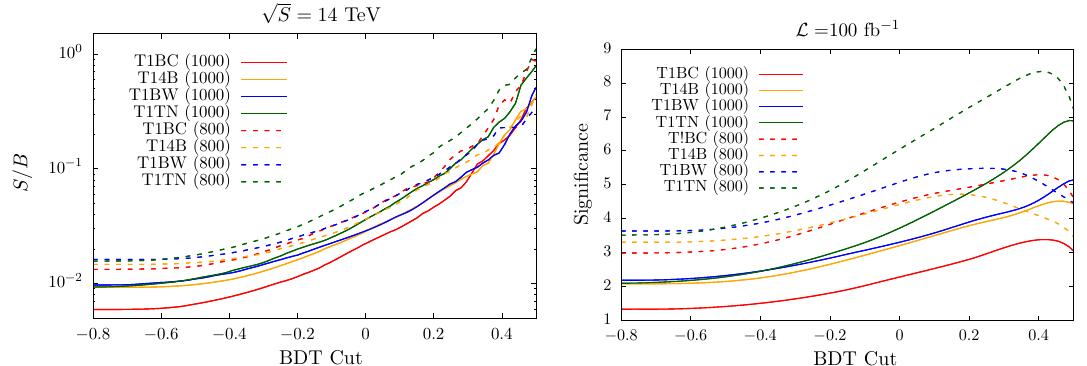
Fig. 5 Left the signal-background ratio for varying BDT cut. Right the signal significance at integrated luminosity of 100fb − 1 for varying BDT cut